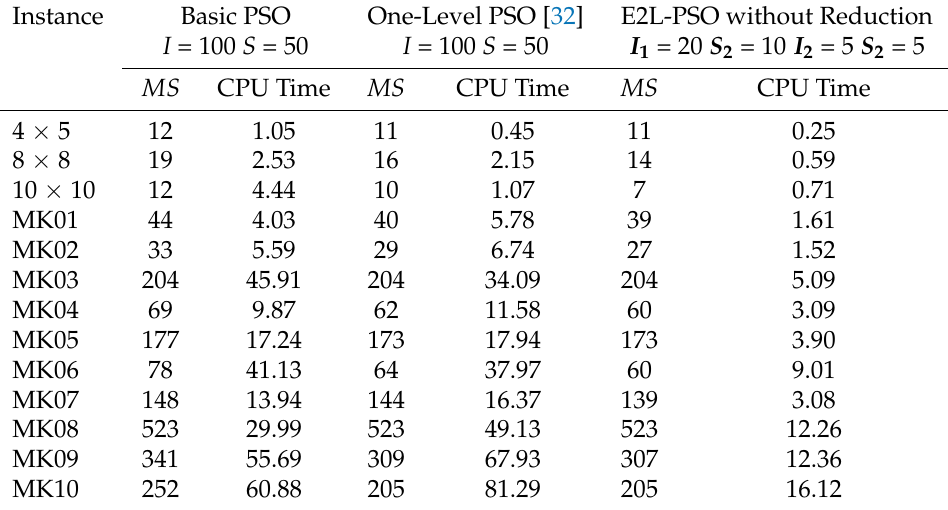
Table 8. Comparison 4 between the three developed PSO variants on Raspberry Pi